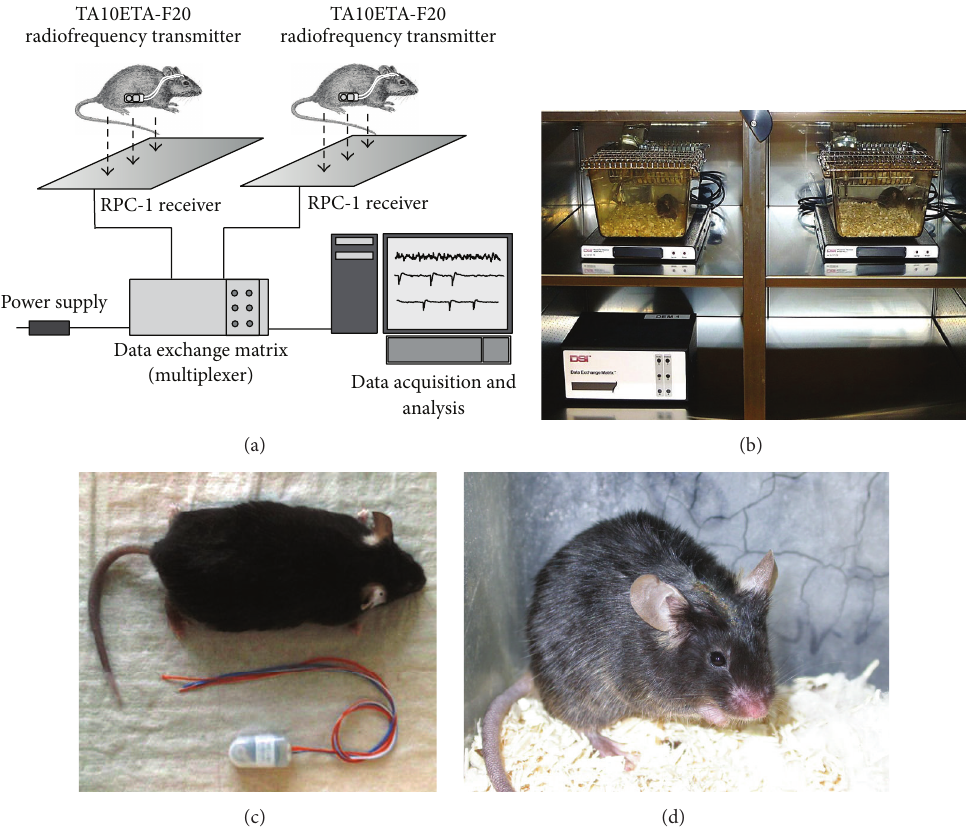
Figure 1: Standard EEG radiotelemetry system and radiofrequency transmitters. Besides self-made systems, a number of commercially available systems are on the market. The basic setup of such system is depicted in (a). The system consists of a radiofrequency transmitter, the receiver plate, a data exchange matrix serving as a multiplexer, and the data acquisition, processing, and analysing core unit. For frequency analysis, seizure detection and sleep analysis specific software modules are offered. Multiple types of transmitters are available depending on which species is supposed to be investigated and depended on the scientific question. (b) Implanted mice, receiver plates, and a multiplexer placed inside a ventilated cabinet for standardized recording conditions. (c) An adult C57Bl/6J mouse and a 2-channel radiofrequency transmitter (TL11F20-EET; DSI). (d) Dorsal view of the skull 4 weeks after electrode implantation and fixation using glass ionomer cement. Figures 1(a) and 1(d) reprinted from [85], with permission from